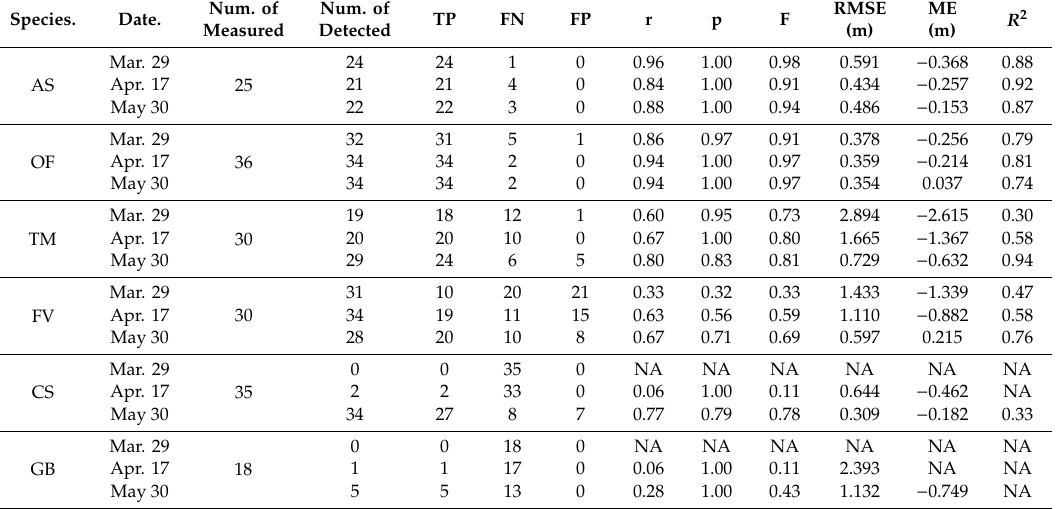
Table 6. Individual tree detection results and height estimation accuracy on the three dates. TP (true positive), FN (false negative), FP (false positive), recall ( r ), precision ( p ), F (F score), RMSE, and ME are presented using the field measurements as references.